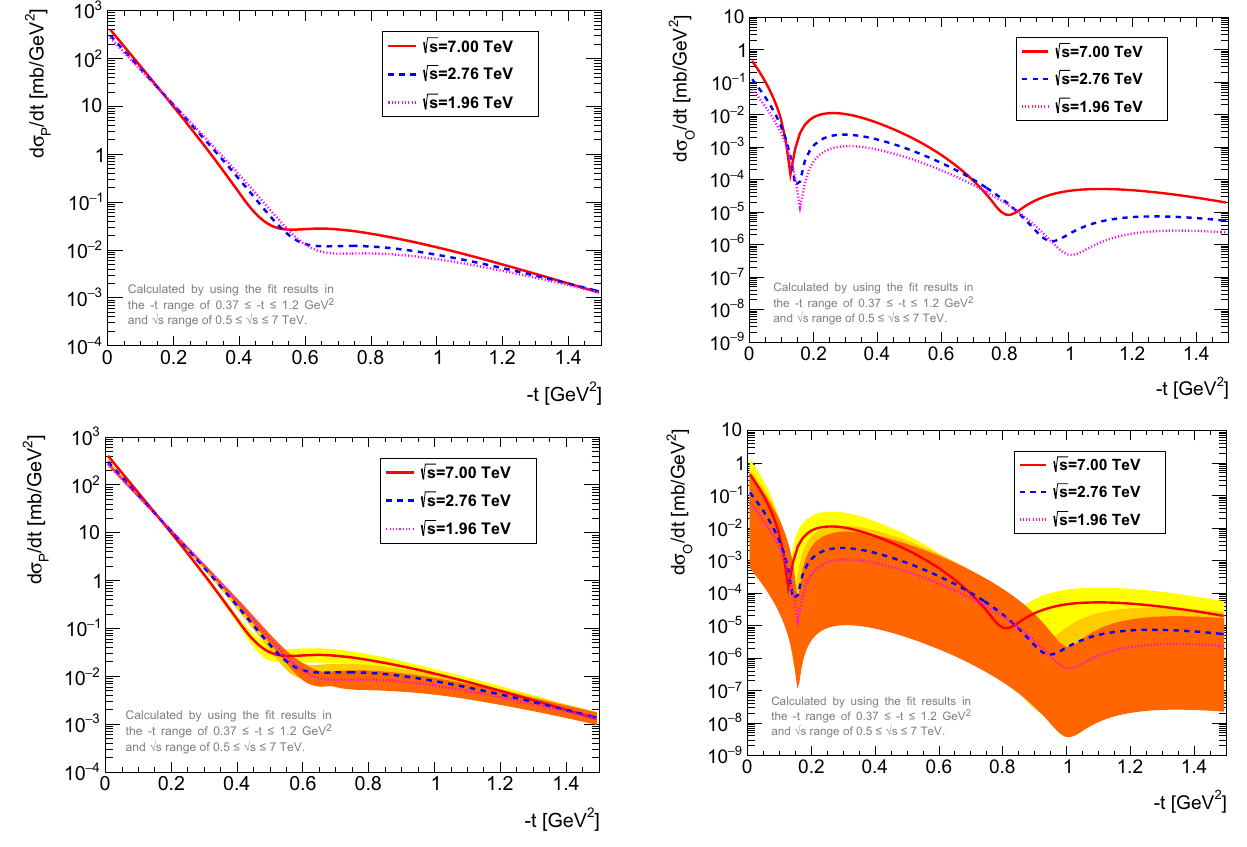
Fig. 21 The differential cross-section of Pomeron exchange, as calcu- lated from ReBB model of Ref. [36], based on the log-linear excitation functions of α pp ( s ) , α p ¯ p ( s ) and the scale parameters, R q ( s ) , R d ( s ) , R qd ( s ) , corresponding to Fig. 6 as summarized in Table 2 in the body of this manuscript. The top panel indicates the central values, while the lower panel includes our first estimates on the systematic errors of this reconstruction. The presented (over)estimates of the systematic error bands were obtained by neglecting the possible correlations between the parameters p 0 and p 1 for each of the excitation functions given in Table 2